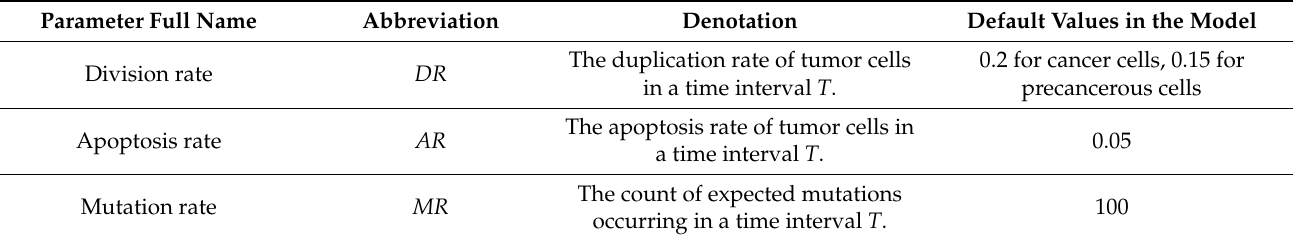
Table 1. Parameters in the